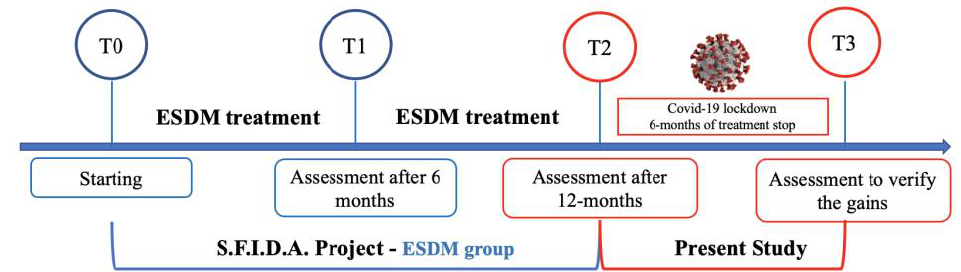
Figure 1. The workflow of the study. T0 baseline, T1 after six months, T2 after 12 months of the intervention and T3 after six months of treatment interruption.